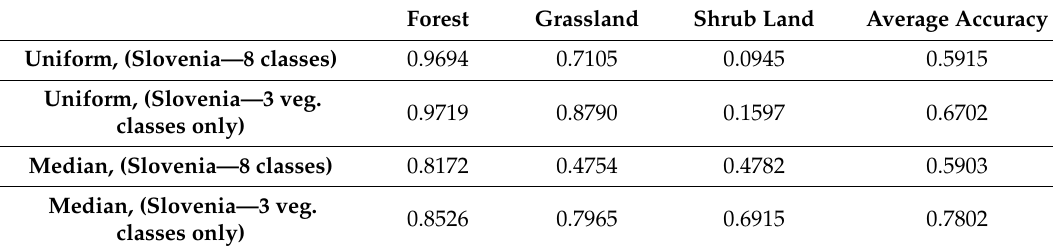
Table 11. Vegetation class accuracy comparisons for three and eight class models in DeepLabV3 +